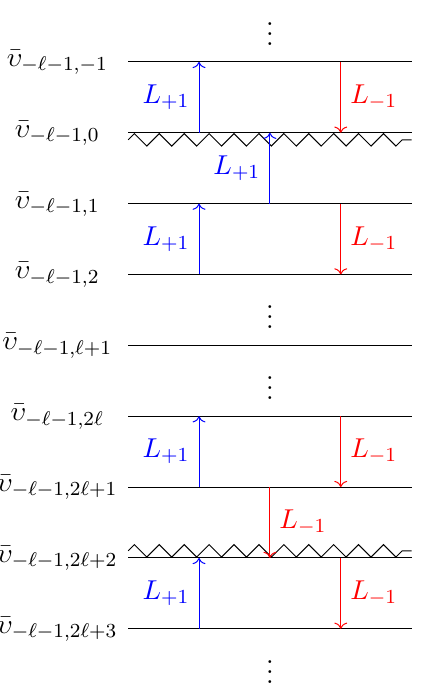
Figure 2 . The infinite-dimensional representation of SL (2 , R ) whose elements solve the near zone equations of motion for a massless scalar field in the Schwarzschild black hole background with multipolar index ‘ and contain the singular static